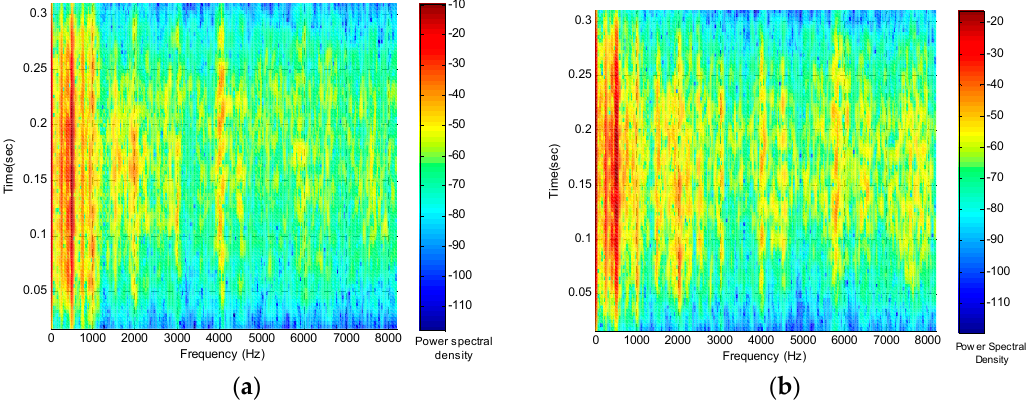
Figure 4. ( a ) Short-time Fourier Transform for a gear with a partially damaged tooth; and ( b ) short-time Fourier Transform for a healthy gear.